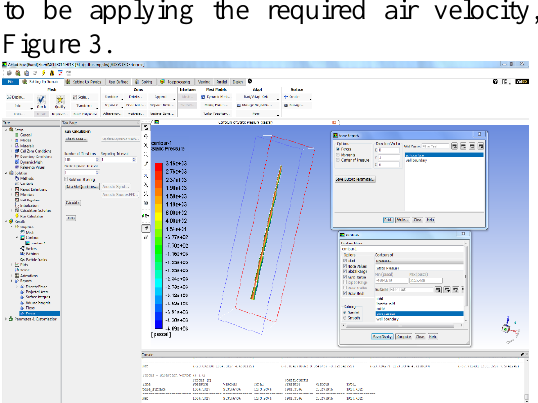
Fig. 3. The Ansys fluent simulation result